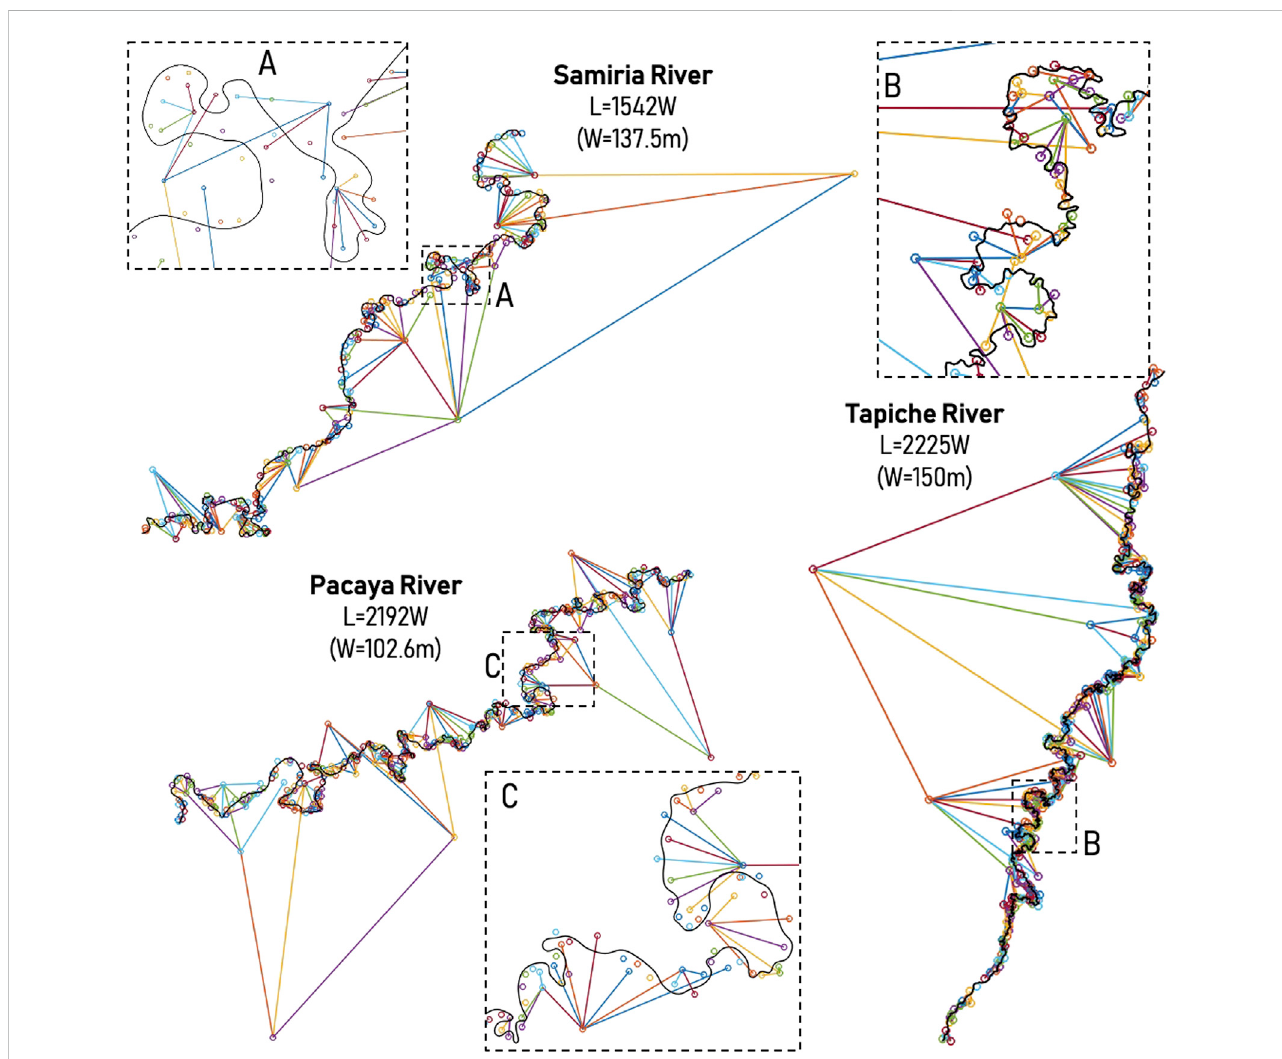
FIGURE 6 Hierarchically ordered in a tree using the methodology by Vermeulen et al. (2016). L is the longitudinal scale, and W is the channel width. (A – C) show examples of tree-based scales for the under fi t-scavenger rivers Samiria, Tapiche and Pacaya,